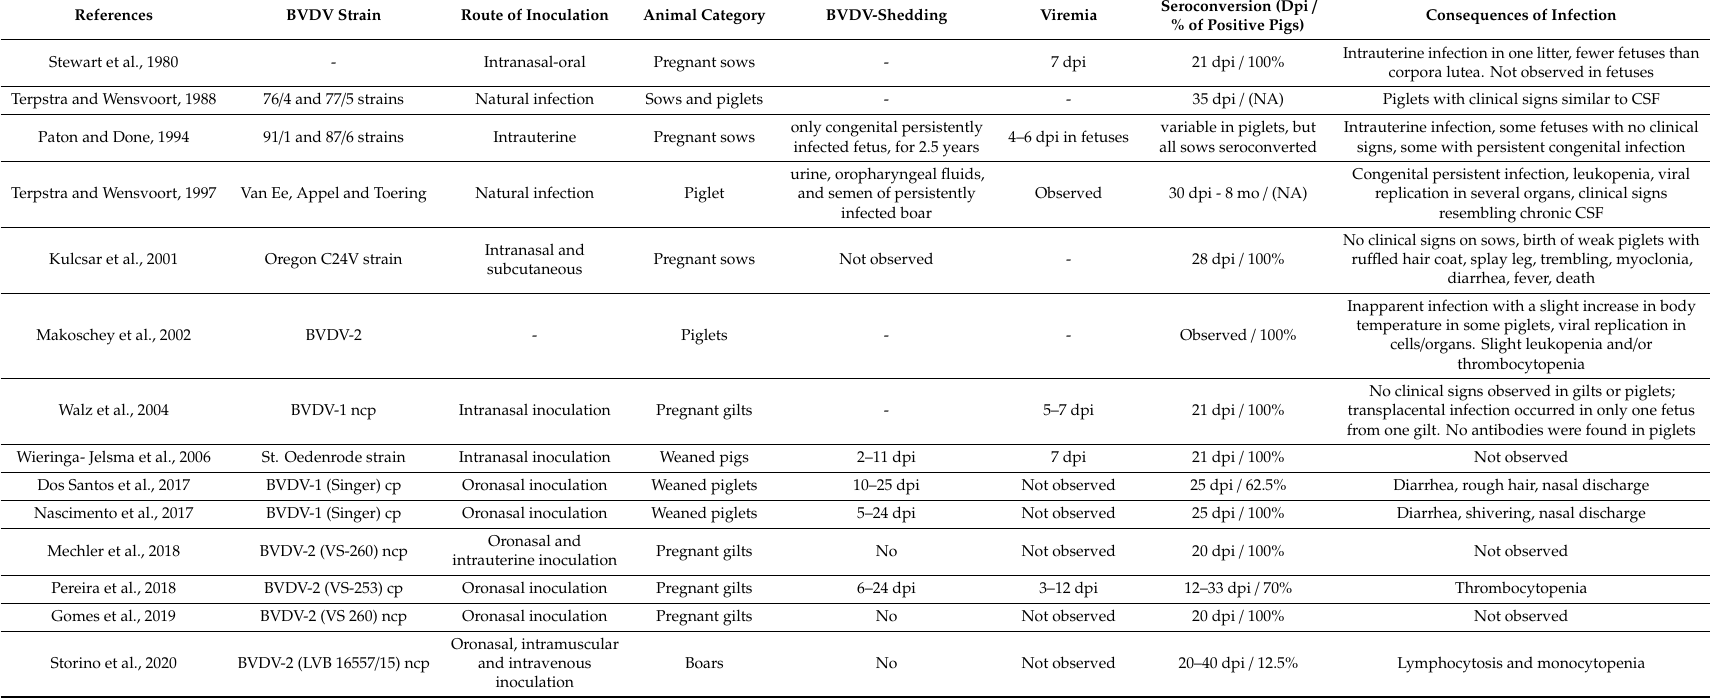
Table 2. Results obtained in experimental inoculation studies of bovine viral diarrhea virus in